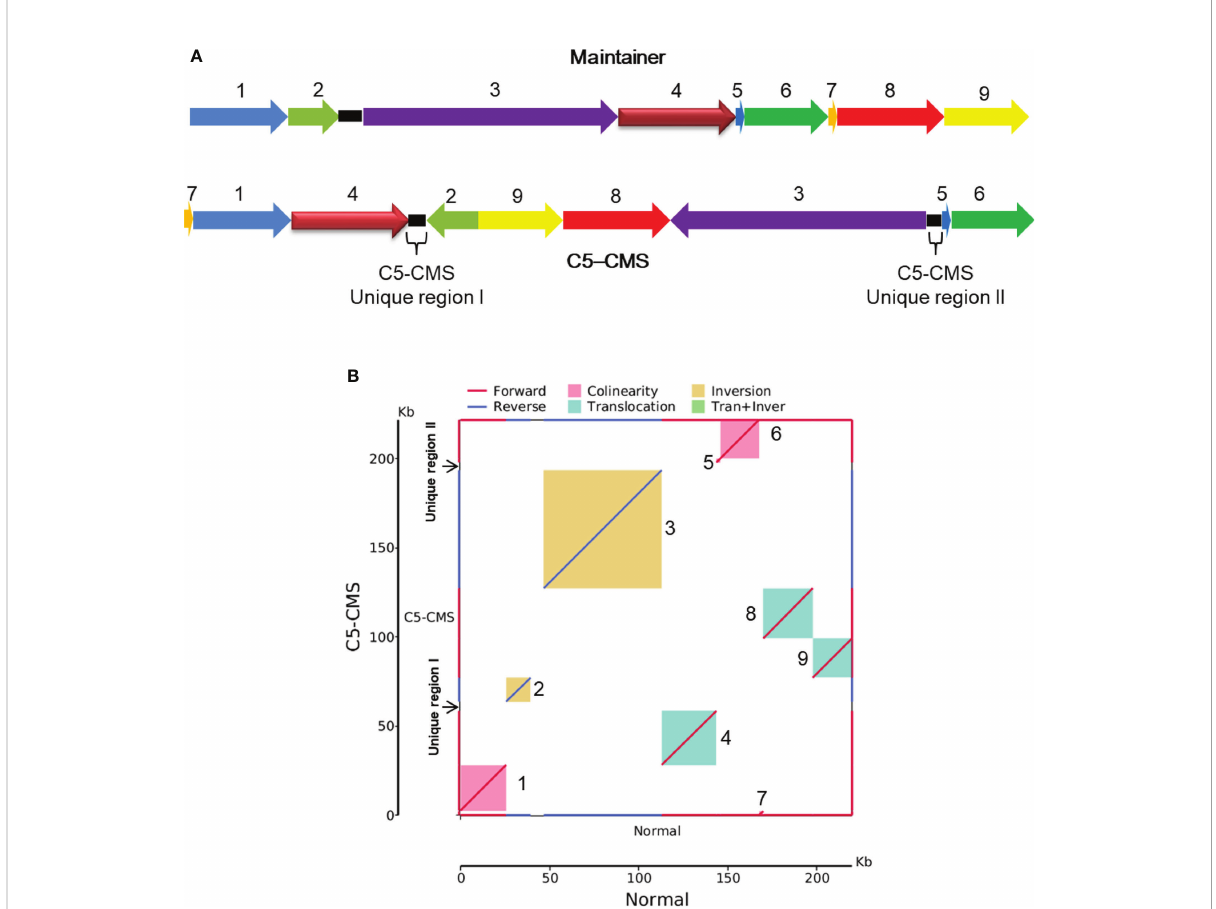
FIGURE 3 Collinearity analysis of the mitochondrial genomes between the maintainer and C5-type CMS lines. (A) Schematic illustration of 9 syntenic regions in the mitochondrial genomes of the maintainer and C5-CMS cabbage lines. The nine syntenic regions were named block 1 to block 9. The C5-CMS line had two unique regions. (B) . Maintainer line genome (X-axis) plotted against the C5-CMS line genome (Y-axis). Red lines indicate forward alignment, and blue lines indicate reverse alignment. The numbers behind the inner squares for the syntenic regions correspond to those indicated in panel (A) The color of the inner bars represents the alignment types. Red color: collinearity; green color: translocation; yellow color: